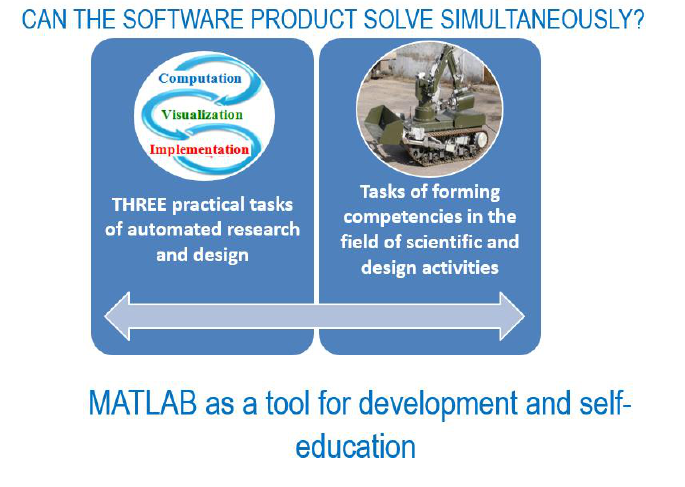
Fig. 7. MATLAB development and self – development